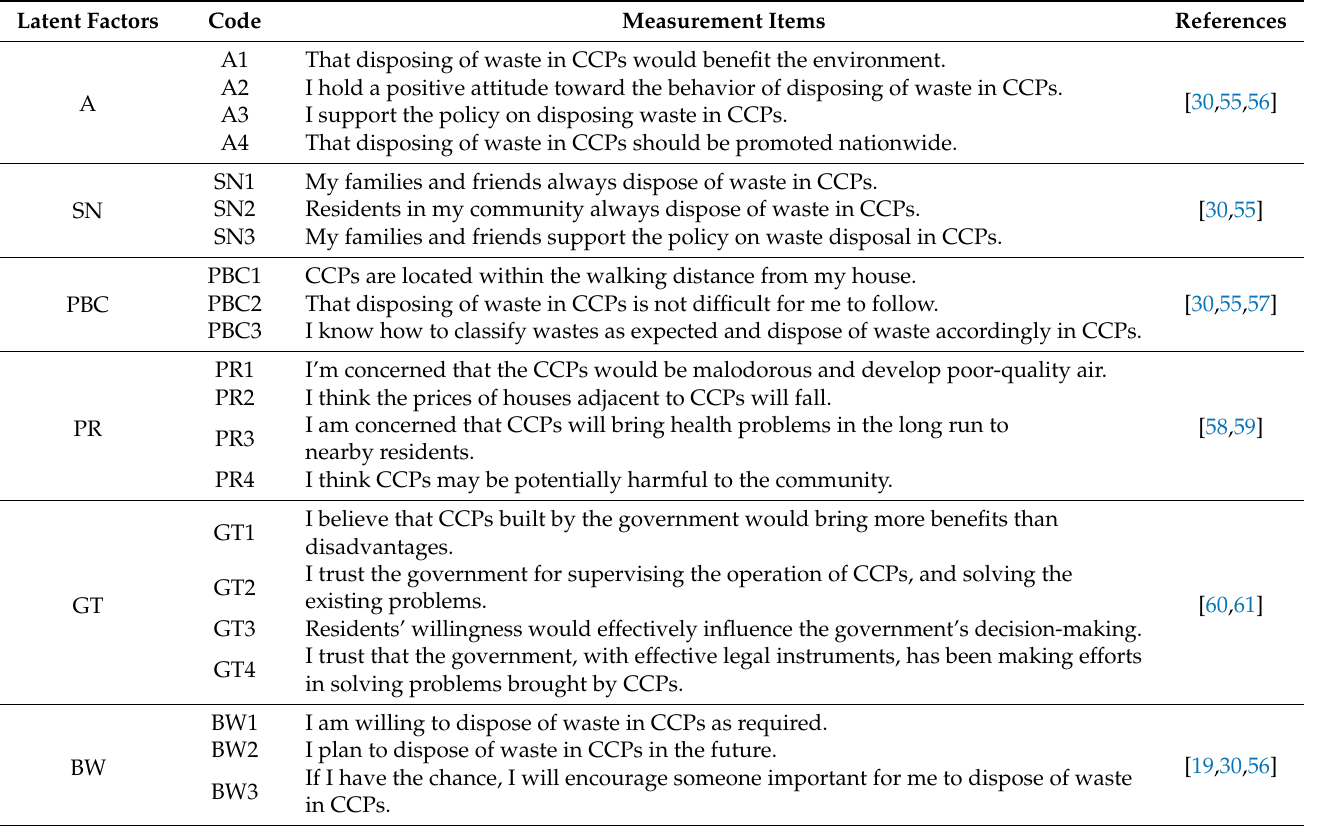
Table 2. Measurement items of the